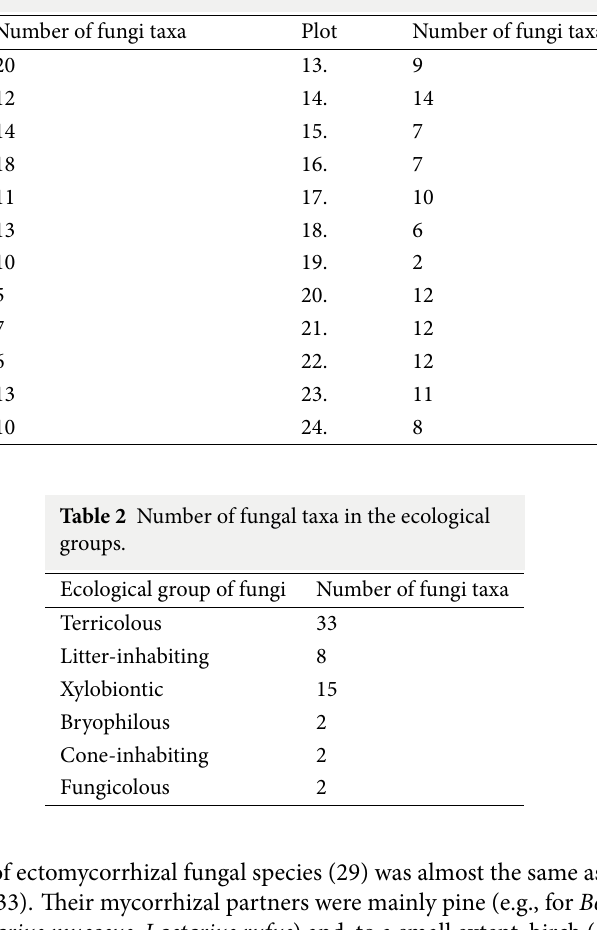
Table 1 Number of fungal taxa identified within the individual permanent plots. Plot Number of fungi taxa Plot